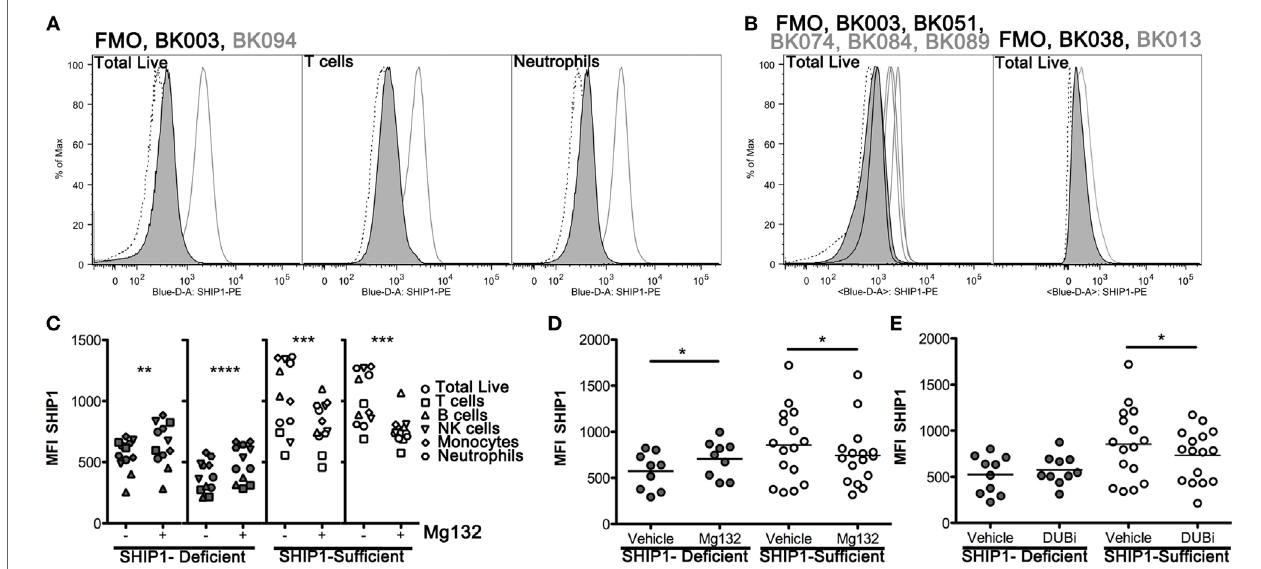
FigUre 5 | SHIP1 deficiency is observed in all major blood lineages and is subject to increased proteasome-mediated degradation in SHIP1-deficient inflammatory bowel disease (IBD) patients. (a) Histograms for SHIP1 staining by intracellular flow cytometry (icFlow) performed on leukocytes from a SHIP1-deficient (BK003, black line-gray fill) and SHIP1-sufficient (BK094, gray line) IBD patient and fluorescence-minus-one (FMO, dotted line). Samples were gated for total live cells, T cells (CD3 + ), and neutrophils (CD15 + CD16 + ). (B) Histograms for total live cells for several SHIP1-deficient (black line-gray fill) and SHIP1-sufficient (gray line) patients, from independent experiments along with FMO (dotted line) for each sample. (c) Leukocytes from two individual SHIP1-deficient (gray) and 2 SHIP1-sufficient (white) subjects were cultured ex vivo for 1 h in the presence of Mg132 ( + ) or Vehicle alone ( − , 0.1% dimethyl sulfoxide final) and analyzed for SHIP1 expression in major blood cell types by icFlow. (D) Effect of Mg132 treatment on total live cells from several subjects. (e) Treatment of cells with pan-deubiquitinase inhibitor PR-619 (DUBi) has opposite effects on total live cells from SHIP1-deficient and SHIP1-sufficients subjects. [For (D,e) , Filled circles: SHIP1-deficient n = 6, Open circles: SHIP1-sufficient n = 9. Two-tailed, paired t-tests, * P < 0.05, ** P < 0.01, *** P < 0.001, **** P <